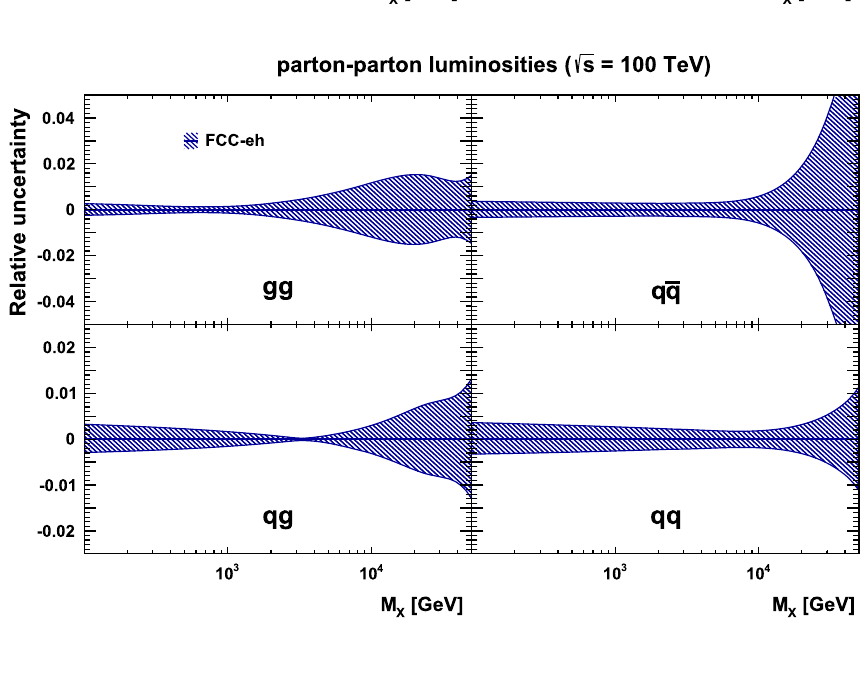
Fig. 5.13 Relative PDF uncertainties on parton-parton luminosities from the PDF4LHC15 and FCC-eh PDF sets, as a function of the mass of the produced heavy object, M X , √ s = 100 TeV. Shown are at the gluon-gluon (top left), quark–antiquark (top right), quark-gluon (bottom left) and quark–quark (bottom right) luminosities